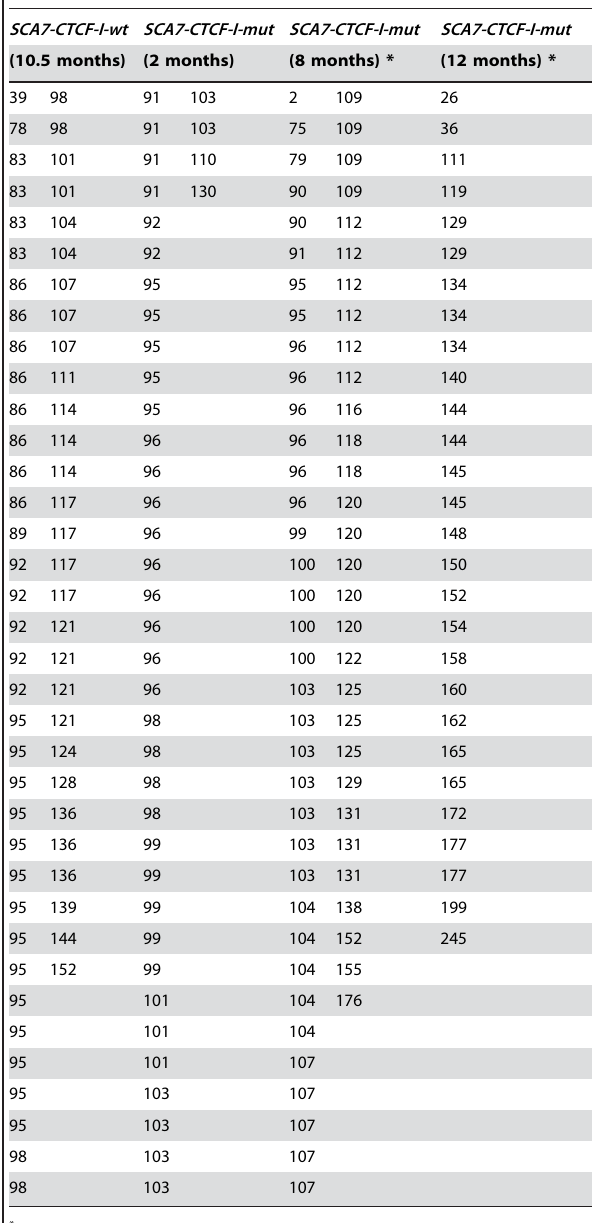
Table 1. Repeat sizes of cortex DNA: CAG tract length - Small- pool